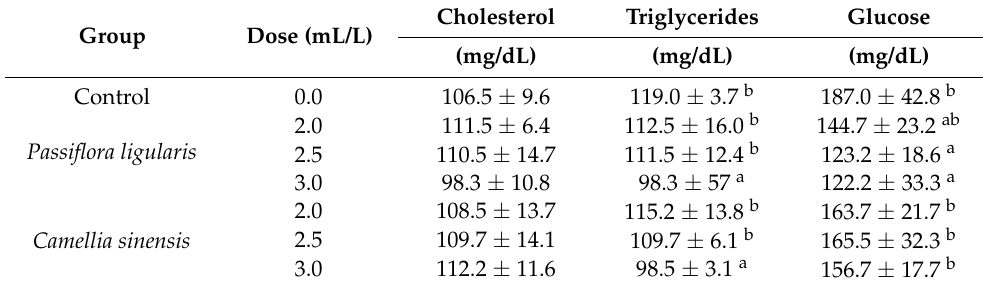
Table 1. Effect of supplementation with polyphenol-rich extracts on metabolic components. Cholesterol Triglycerides Glucose Group Dose (mL/L) (mg/dL) (mg/dL) (mg/dL) Control 0.0 106.5 ± 9.6 119.0 ± 3.7 b 187.0 ± 42.8 b 2.0 111.5 ± 6.4 112.5 ± 16.0 b 144.7 ± 23.2 ab Passiflora ligularis 2.5 110.5 ±